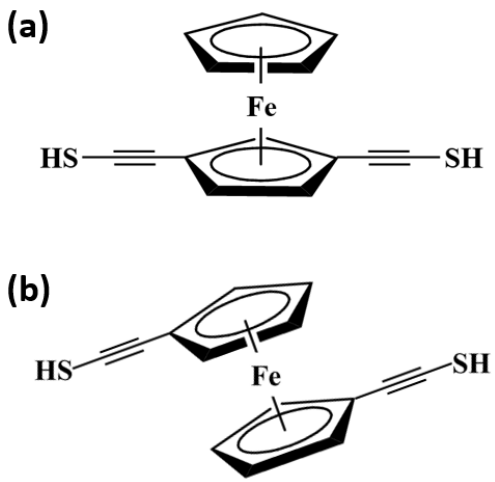
Figure 1. Chemical structures of ( a ) 1,3-substituted and ( b ) 1,3′ -substituted thiolated ethynylferrocene molecules.